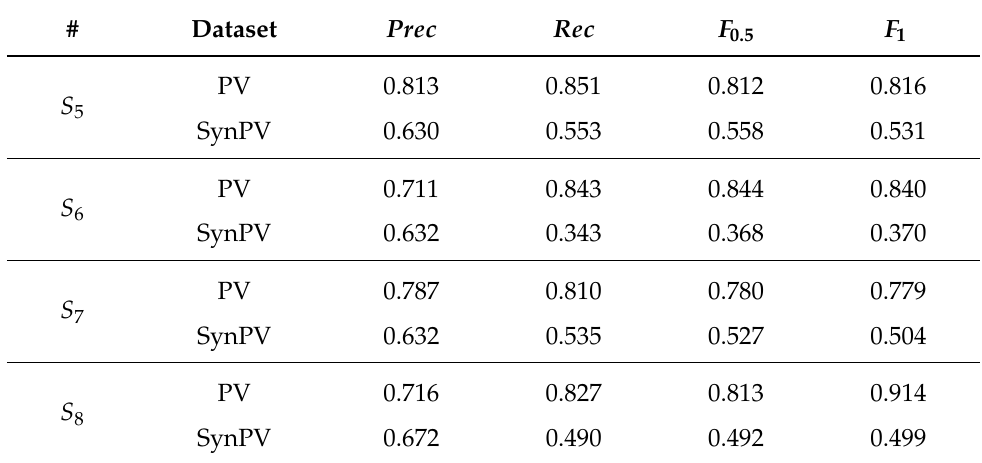
Table 4. Resulting test performance of the model trained with the parameters in Table 2 over the original dataset PlantVillage (PV) and the synthetic one (SynPV), simulating grass on the background. Results are shown with the original proposal using a single camera.